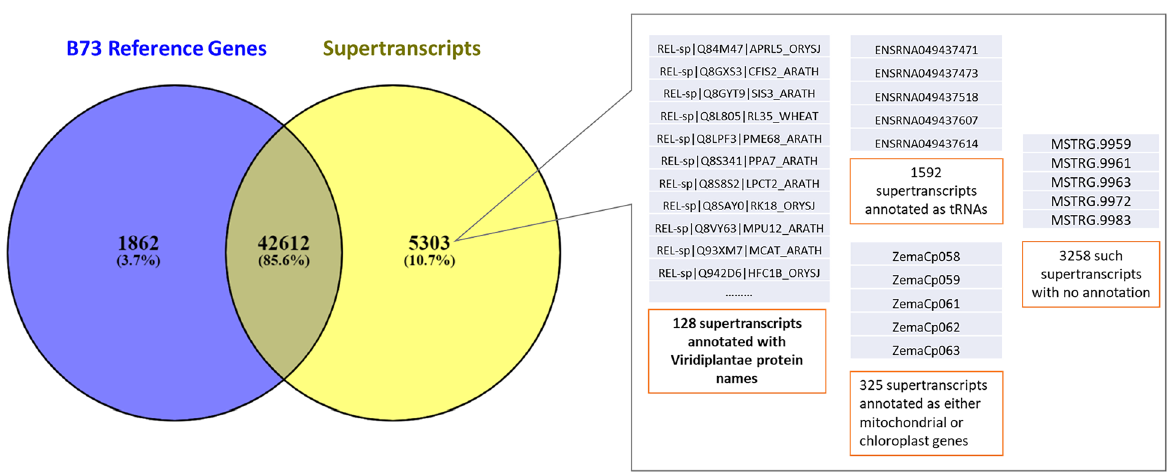
Figure 4. Venn Diagram showing that 42,612 SuperTranscripts identified and annotated with corresponding maize reference gene IDs. Of the remaining 5303, 128 SuperTranscripts were predicted to be coding for certain proteins from the Viridiplantae proteome, 1592 were annotated as tRNAs, 325 were annotated as either mitochondrial or chloroplast genes, and the remaining 3258 were